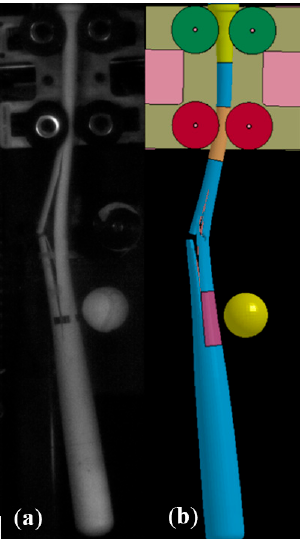
Figure 11. 34-in. (86.4-cm) long, 31-oz. (0.879-kg) professional maple bat profile impacted at 143 mph (230 kph): ( a ) Lab test and ( b ) Finite element model.